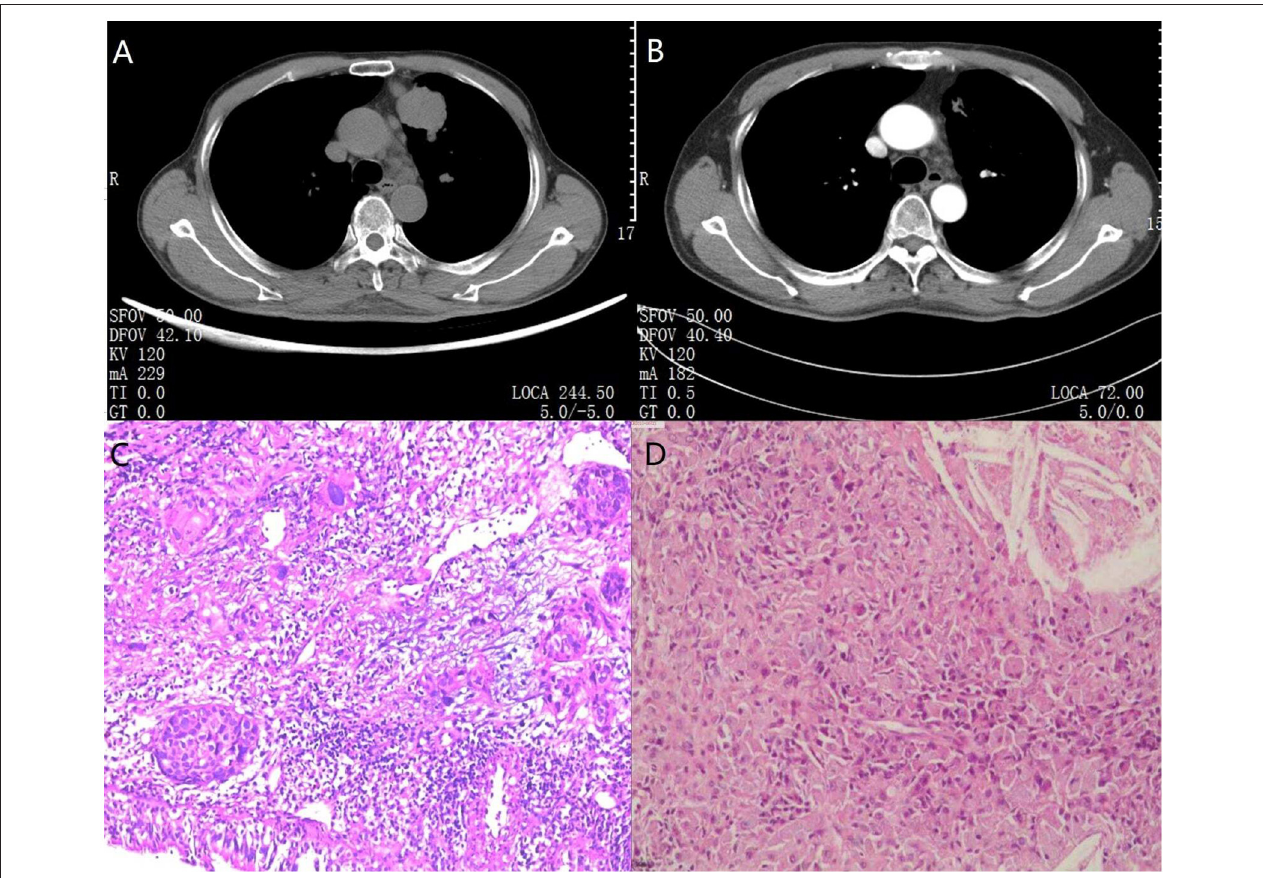
FIGURE 2 | CT pre-treatment and after treatment combined with preoperative and postoperative specimens in one pathological completely response patient. (A) A 69-year-old man diagnosed with left upper lobe squamous carcinoma coupled with metastatic supraclavicular lymph nodes was classified as cT2aN3M0. Chest radiograph showed a large tumor (lung squamous carcinoma) located in the anterior segment of left upper lobe and enlarged aortopulmonary window lymph-nodes can be seen in the mediastinum. (B) After 2 cycles of immuno-chemotherapy, CT at the same level showed dramatic reduction in the size of the mass and number of enlarged lymph nodes. In addition, metastatic supraclavicular lymph nodes had vanished. After a left upper lobectomy and lymph node dissection, the patient recovered well and has not relapsed to date. (C) The results of percutaneous needle biopsy showed lung squamous carcinoma. (D) The postoperative pathological specimen indicated lack of residual lung cancer cells and lymph node metastasis. Only multinucleated giant cells and fibrotic tissue were observed. The magnification was 40 × for (C/D).